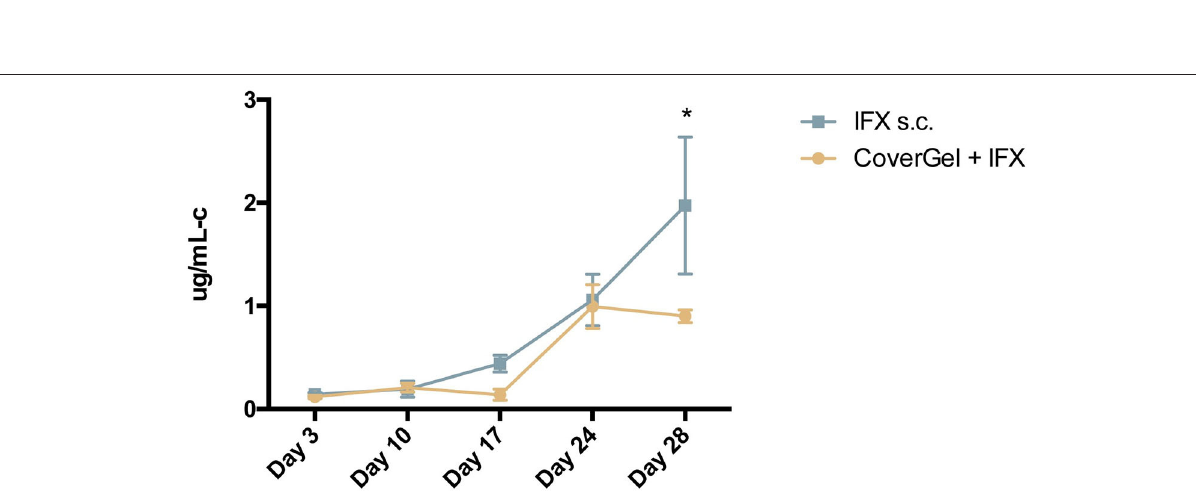
Frontiers in Medicine |